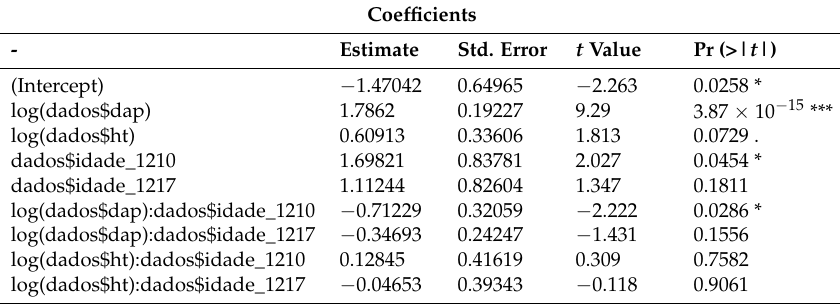
Table A14. R software output table with significance values resulting from ANCOVA for AGFM using C 12 as reference for comparison with C 10 and C 17.